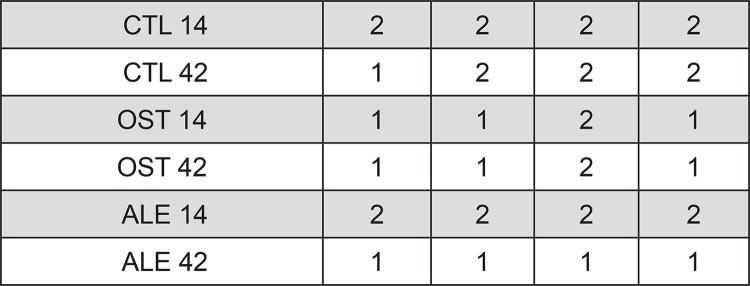
Scores observed in the marking of RUNX2, OP, OC and ALP proteins, in the different experimental groups